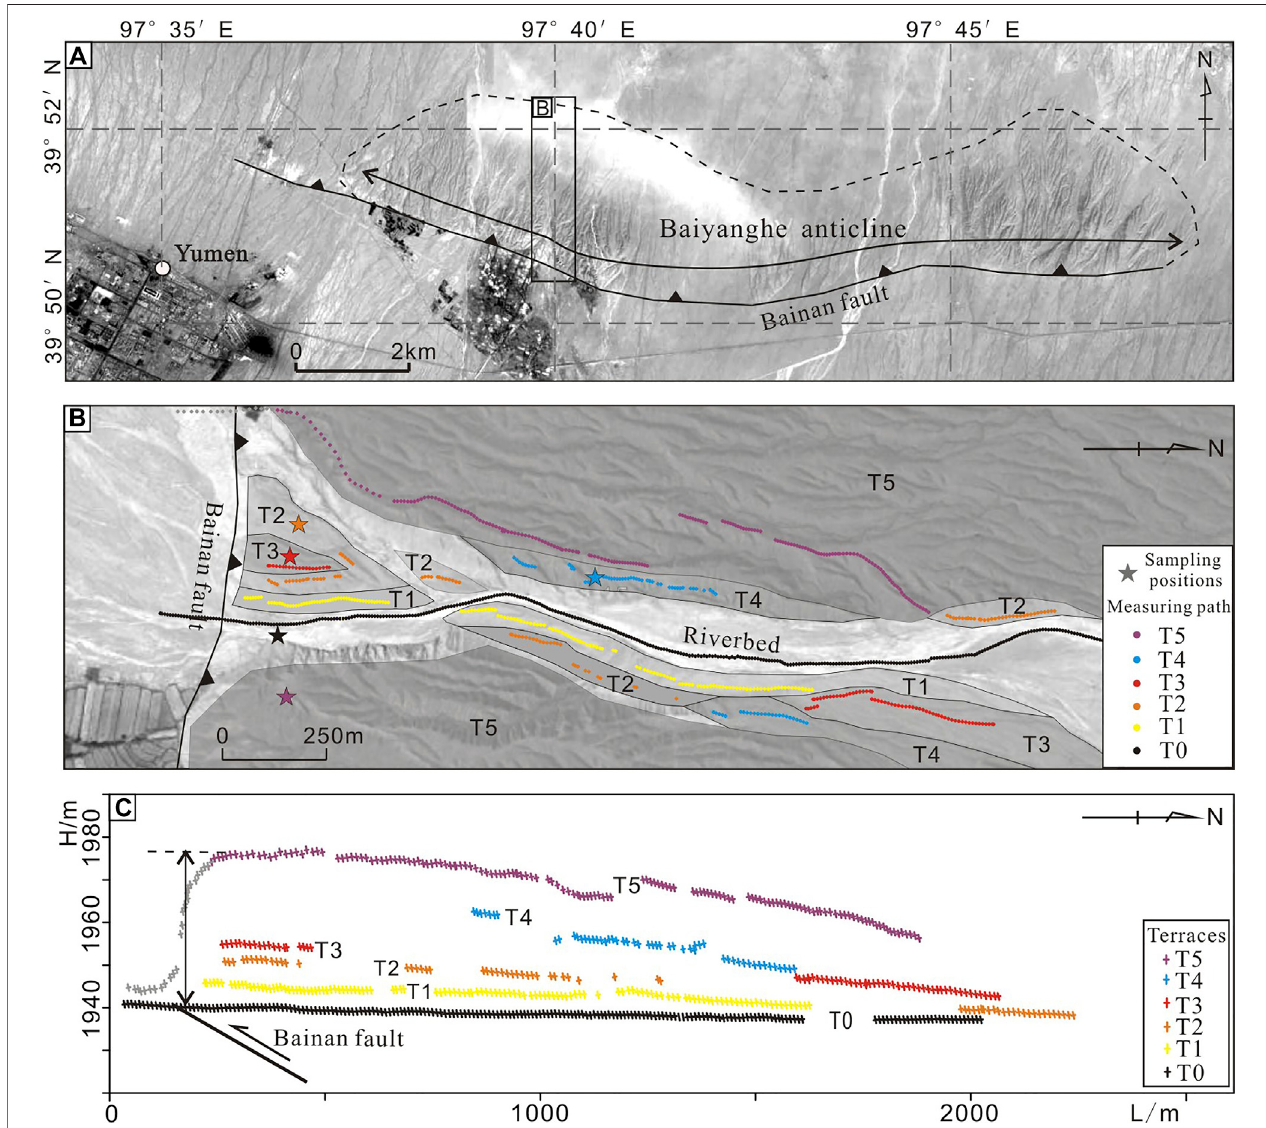
FIGURE 7| (A) Satellite imageof the Baiyang river near the Bainan fault. The image range is shown in the black rectangle of Figure 8A . (B) The distribution map of terracesalongtheBainanfault.Thecoloreddotsdenotethemeasuringpathsofterraces.Thecolored fi ve-pointed starsshowthe 10 Besamplingpositions.Therangeof the measurement is shown in the black rectangle of panel (A) . (C) The longitudinal pro fi les of terraces (T1 – T5) and the modern riverbed (T0) of the Baiyang river. The measuring paths are the yellow dots shown in the panel (B) (Liu et al., 2017a; revised).